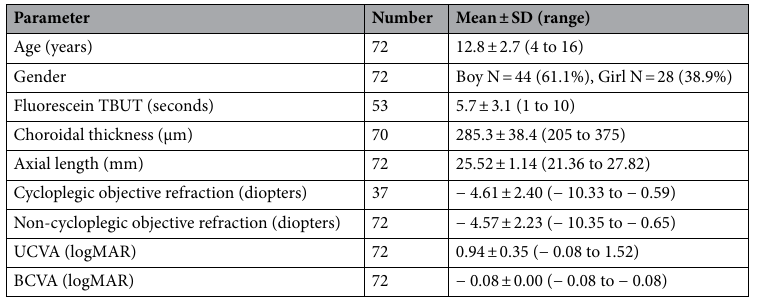
Table 1. Subject demographic data. Data are expressed as the mean ± standard deviation. SD standard deviation, TBUT tear film breakup time, UCVA uncorrected visual acuity, BCVA best-corrected visual acuity, logMAR logarithm of the minimum angle of resolution. The respective number of cases are